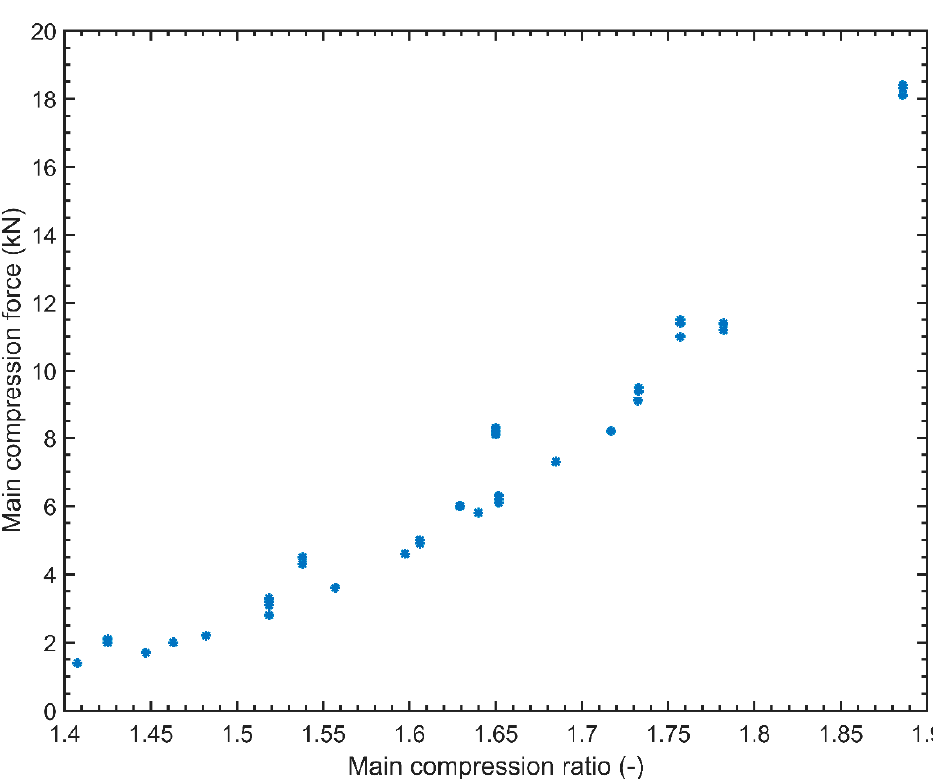
Figure 3. Main compression force (experimental data). Main compression ratio = FD/MCH.